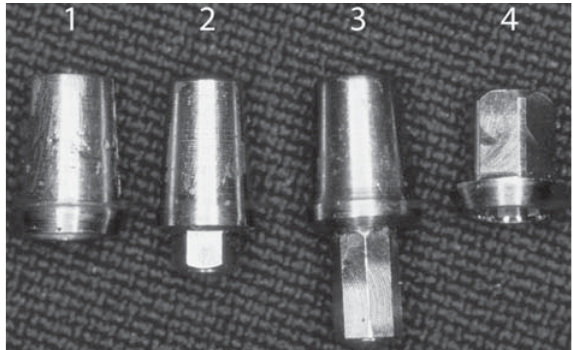
Figure 3- Prosthetic abutments used in the study. (1) UCLA Gold Abutment – groups 1 and 4; (2) Internal Hexagon Premachined Ti – group 2; (3) Internal Octagonal Premachined abutment – group 3; (4) Ceraone Ti – group 5